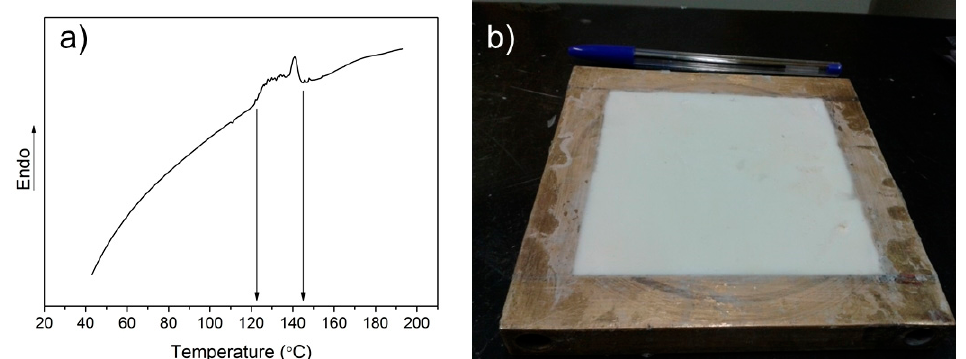
Figure 1. ( a ) Dynamic DSC thermogram of the expandable microspheres. ( b ) Fully expanded epoxy foam (100 °C and 3 min).